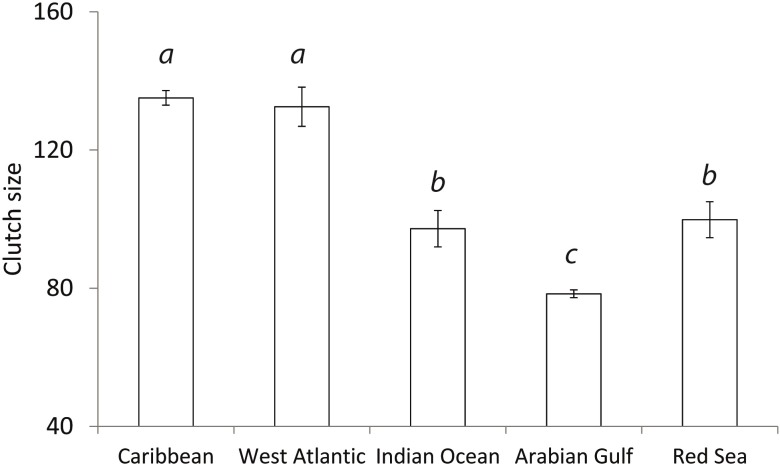
Comparison of clutch sizes from different regions.Significant difference found between regions (ANOVA: F4,412 = 156.2; p<0.01). Data for the Arabian Gulf was from the present study and Pazira et al. (2016); raw data from the Caribbean was collected from Xavier et al. (2006); Ross (1980) provided data from the Indian Ocean; Red Sea data was from Hirth and Abdel Latif (1980) and West Atlantic data was from Marcovaldi et al. (1999). Regions with significantly different clutch sizes are represented by superscript letters above the bars.